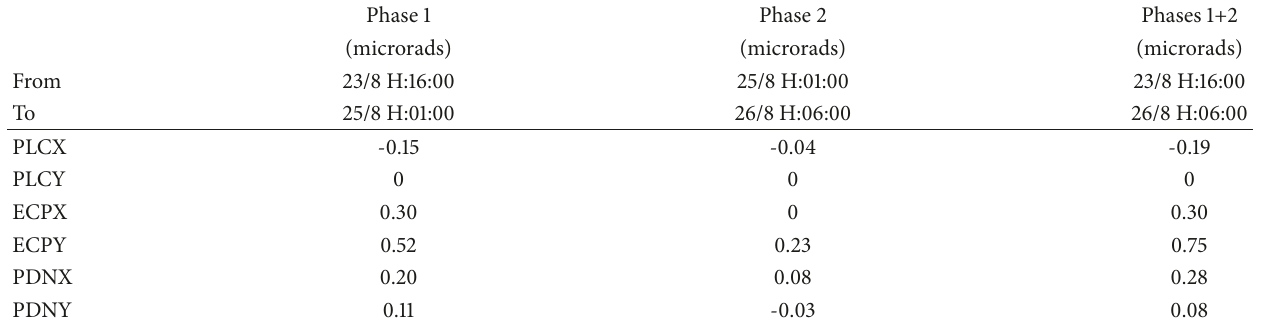
Table 2: Measured tilt variations during the phases of volcanic activity shown in Figure 5, at the three tilt stations. Phase 1